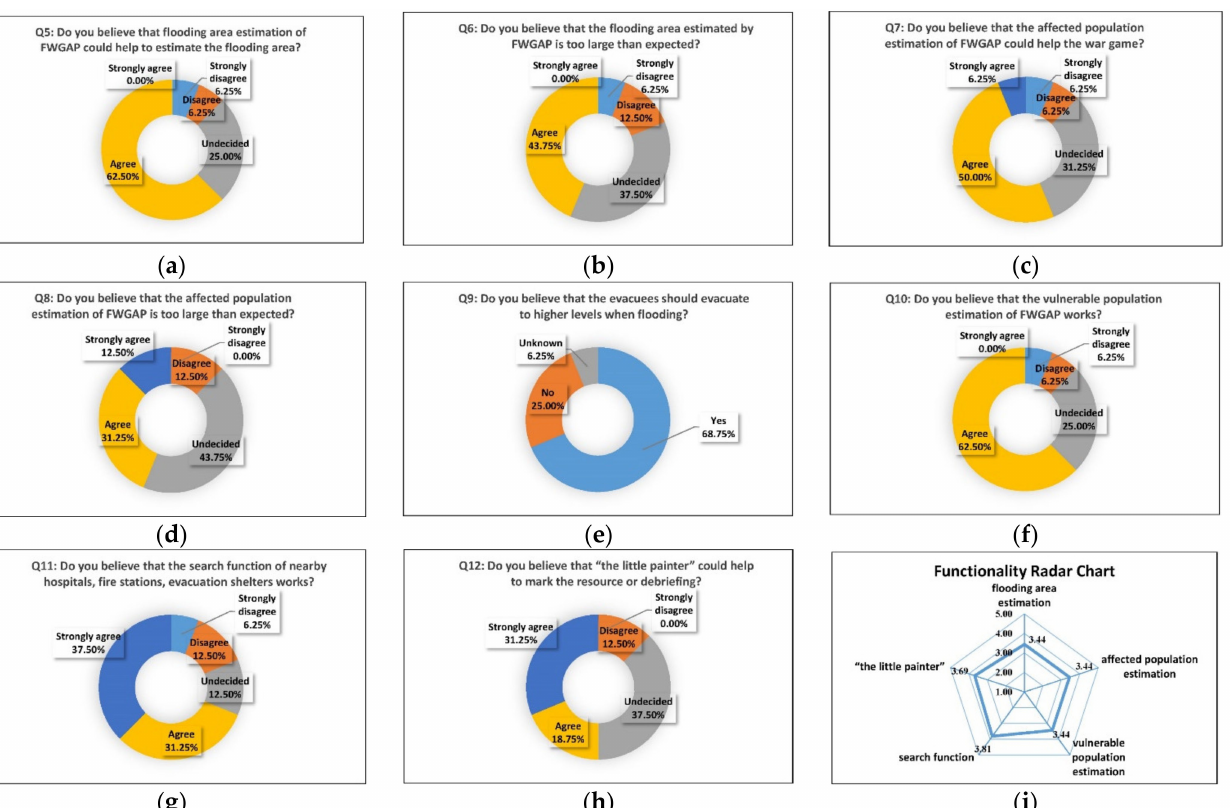
Figure 22. Assessment of the platform’s functionality: ( a ) flooded area estimation, ( b ) if estimated area is larger than expected, ( c ) affected population estimation, ( d ) if estimated, affected population is larger than expected, ( e ) evacuees evacuate to higher ground, ( f ) vulnerable population estimation, ( g ) search function, ( h ) little painter, and ( i ) radar